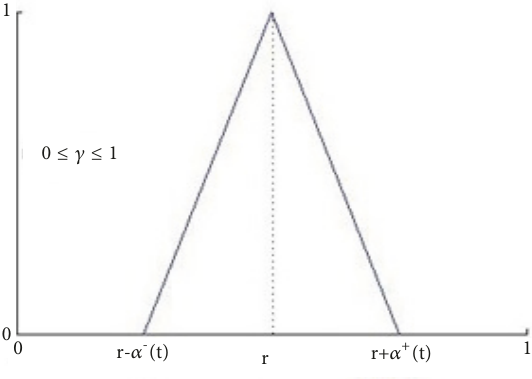
̃ 𝑏 ̃ 𝑏 ̃𝑐 ̃𝑐 1 , 1 and 2 , 2 have a symmetric 𝛽 𝛽 𝜅 𝜅 1 , 2 and 1 , 2 . The rationale